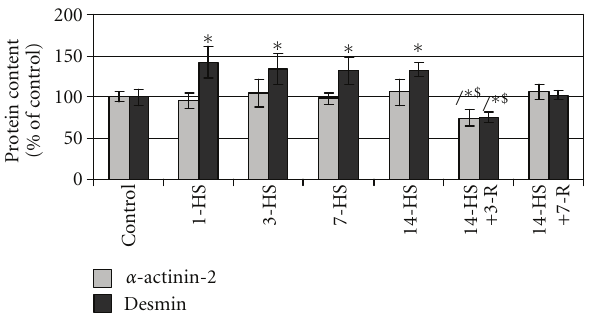
Figure 1: Protein content in the rat’s left ventricular myocytes under gravitational unloading and subsequent reloading; n = 7 samples for each group; ∗ P < 0 . 05 as compared to the group “Control”, $ P < 0 . 05 as compared to the group “14-HS”.